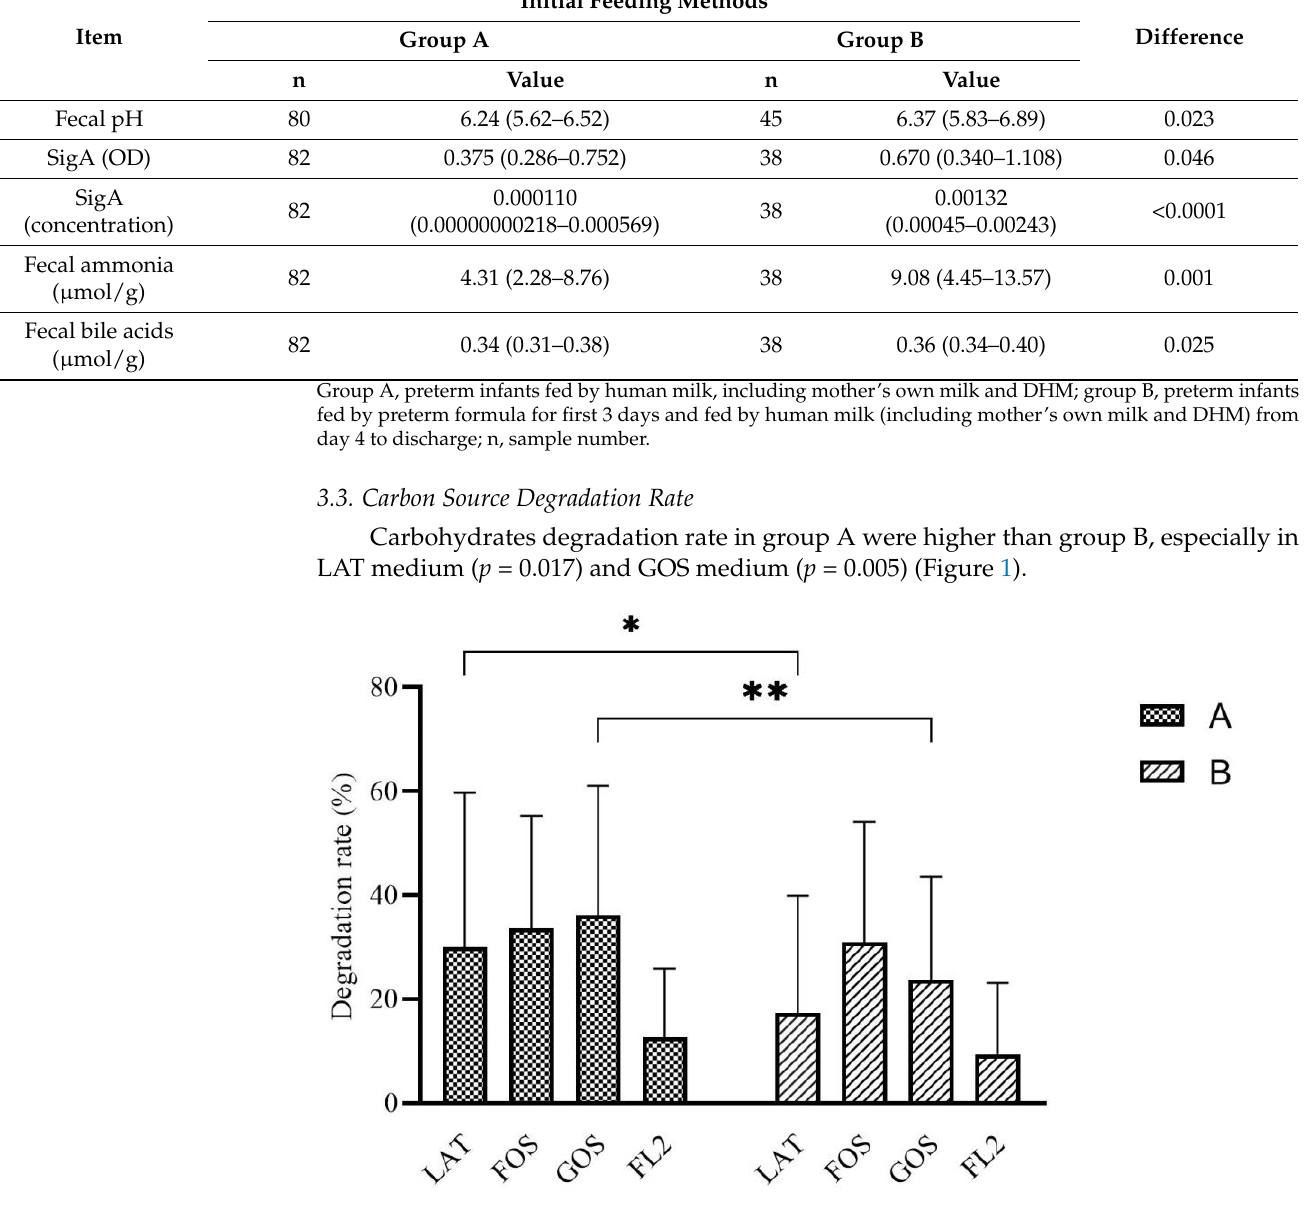
Table 2. Original fecal characteristics.